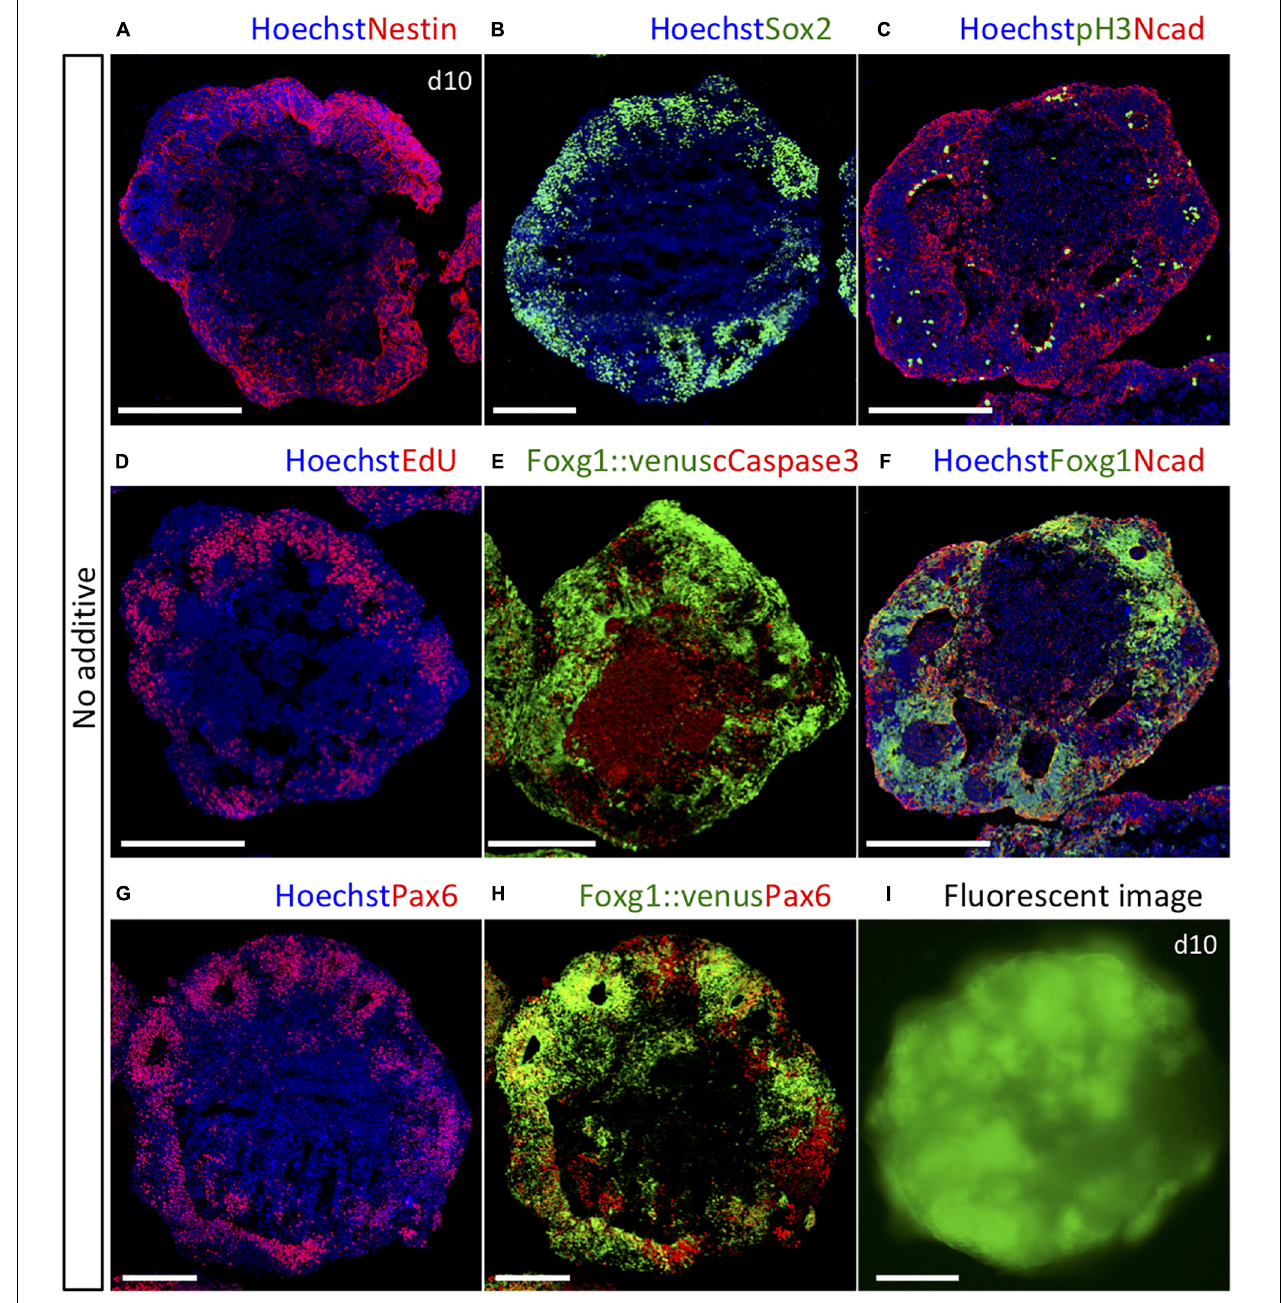
FIGURE 1 | Foxg1::venus cell aggregates cultured in the default condition with no added cues. (A) Nestin + neural lineage-committed cells were observed in most part of the outer zone. (B) Sox2 + neural progenitor cells were observed in the outer zone. (C) N-cadherin + adherens junctions and pH3 + mitotic cells were located at the inner border of the outer zone. (D) EdU + proliferating cells were dominantly located in the outer zone. (E) Cleaved caspase-3 + apoptotic cells were mostly retained in the inner cavity. (F–H) Majority of cells co-expressed Foxg1 and Pax6, indicating cortical fate. (I) Whole-mount fluorescence image of a Foxg1::venus aggregate. All aggregates were analyzed on day 10. Hoechst 33342 (blue), nuclear staining. Scale bars, 200 µ